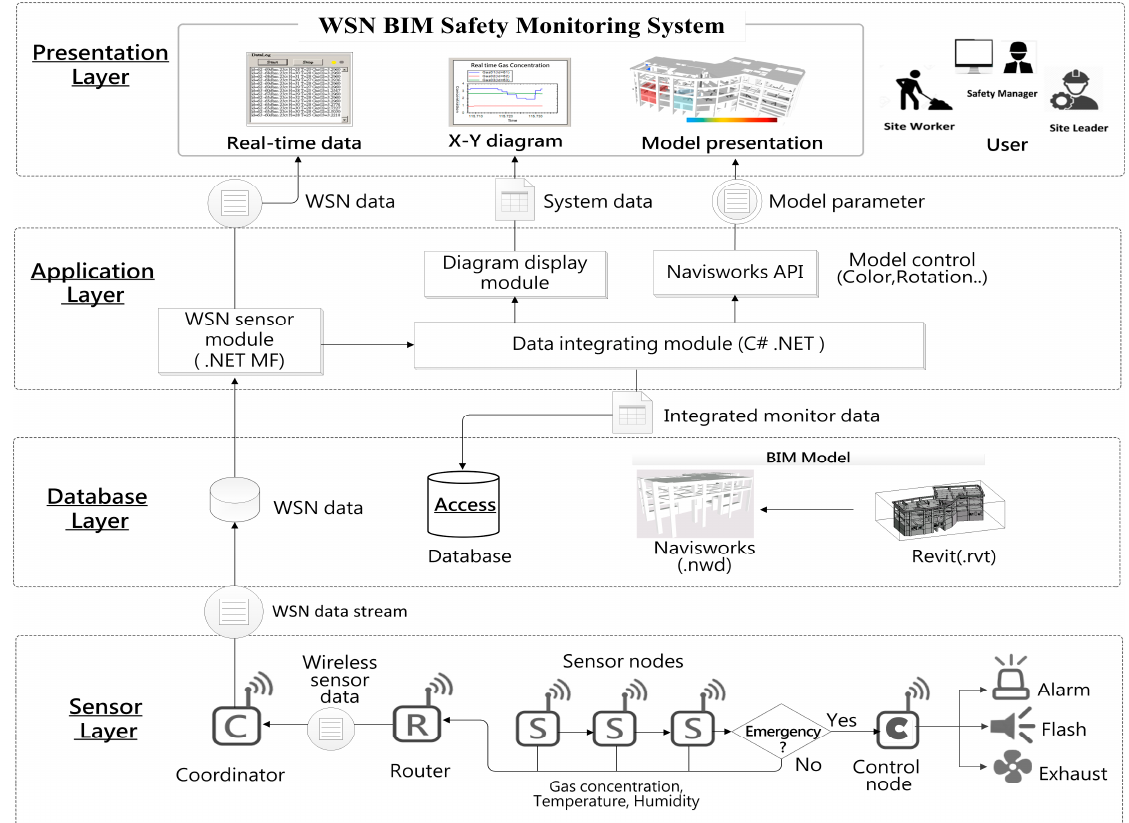
Figure 2. The multi-tier architecture and data flow of the system.